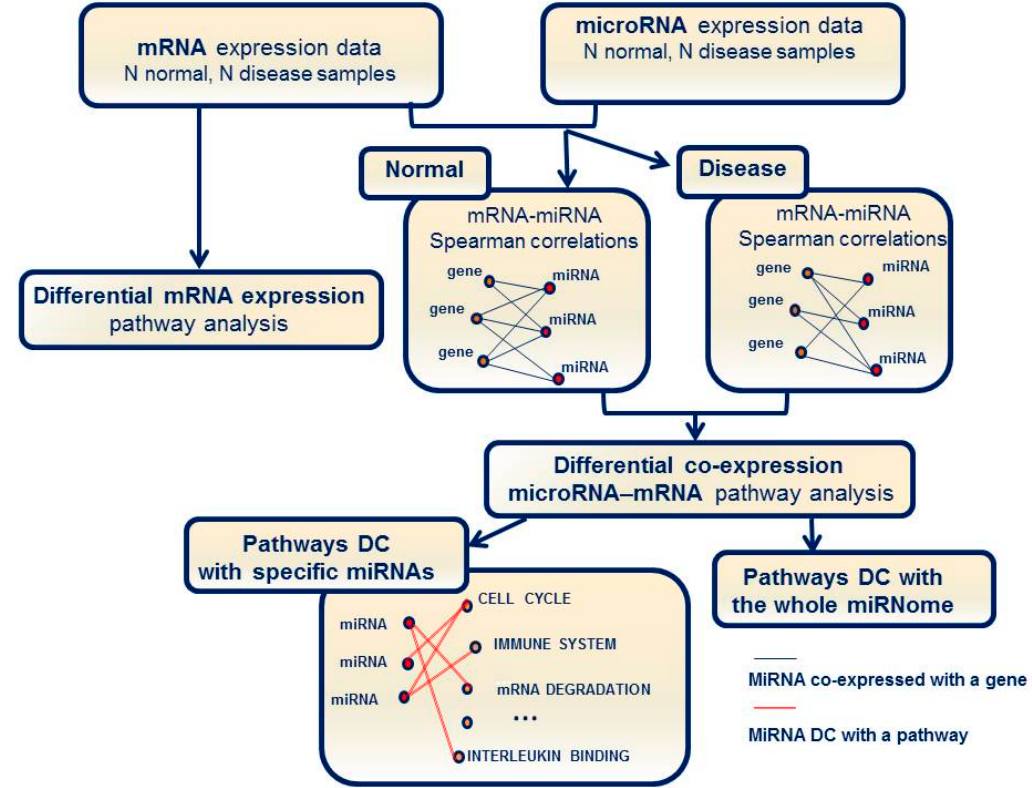
Figure 1. Schematic data and analysis workflow of differential expression (DE) in mRNA and miRNA as well as differential co-expression (DC) analyses.